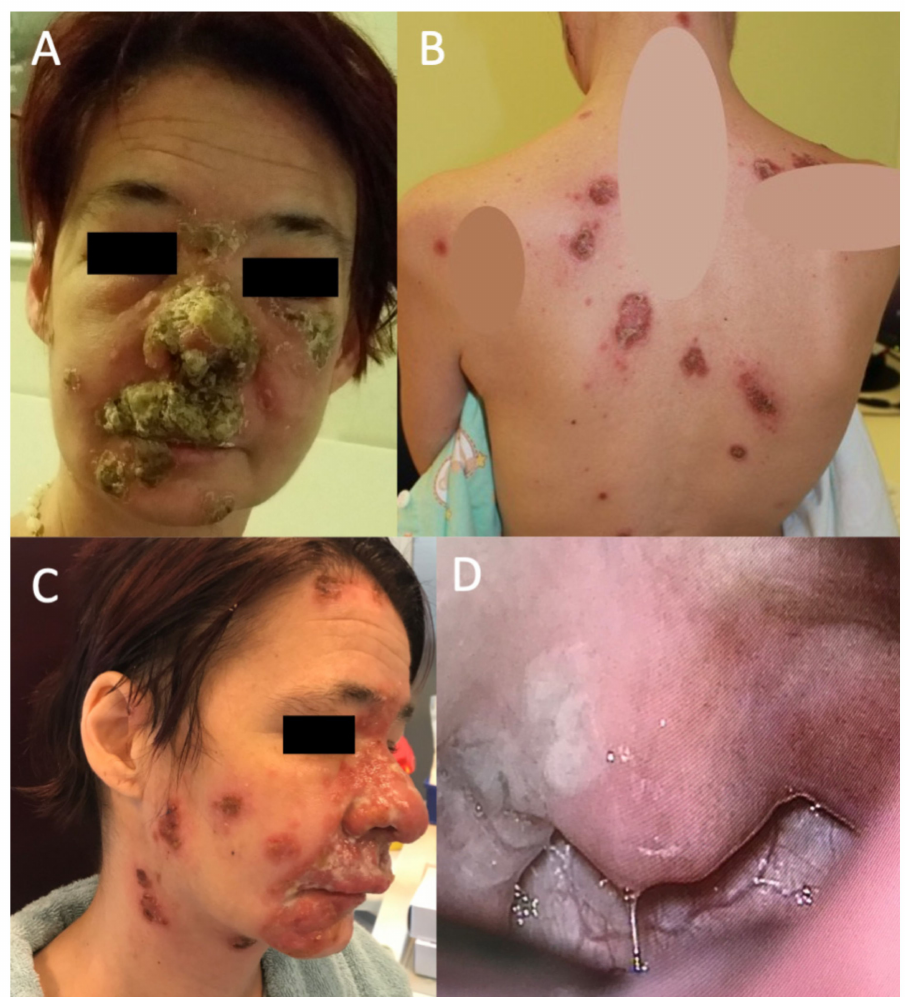
Figure 1. Female patient with malignant syphilis. ( A ) Extensive plaques with crusts and erosions on her face at initial presentation. ( B ) Annular lesions with crusts on the torso (tattoos are concealed). ( C ) Extensive plaques, ulcers and erosions. Crusts were removed with ointment treatment. Diffuse swelling of the nasal soft tissues is visible. ( D ) Right-sided tonsillar plaque, consistent with syphilitic angina. The posterior oropharyngeal wall is hyperemic ( N.B. enhanced vascular